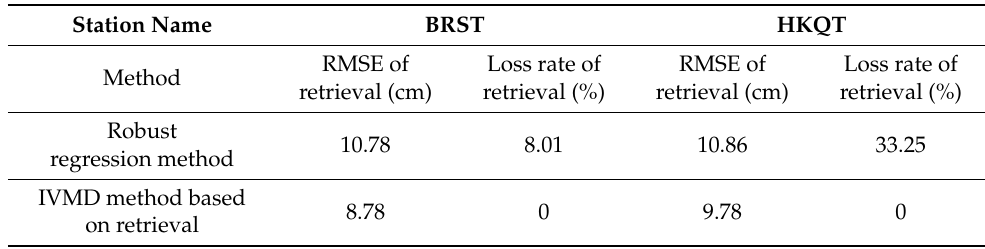
Table 3. RMSE and data loss rate of retrieval used in robust regression method and the IVMD algorithm for BRST and HKQT